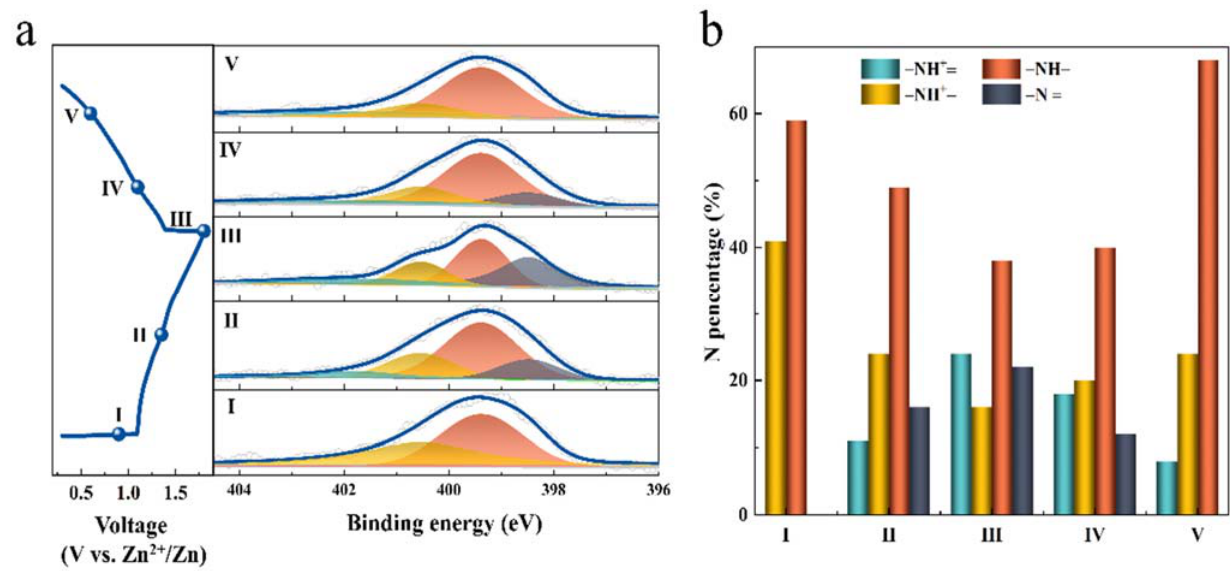
Figure 5. Structure evolution of PANI electrode during cycling. ( a ) Evolution of ex situ N 1s XPS spectra during the charge/discharge process labeled as I − V in the left panel. ( b ) The calculated N contents from N 1s XPS.